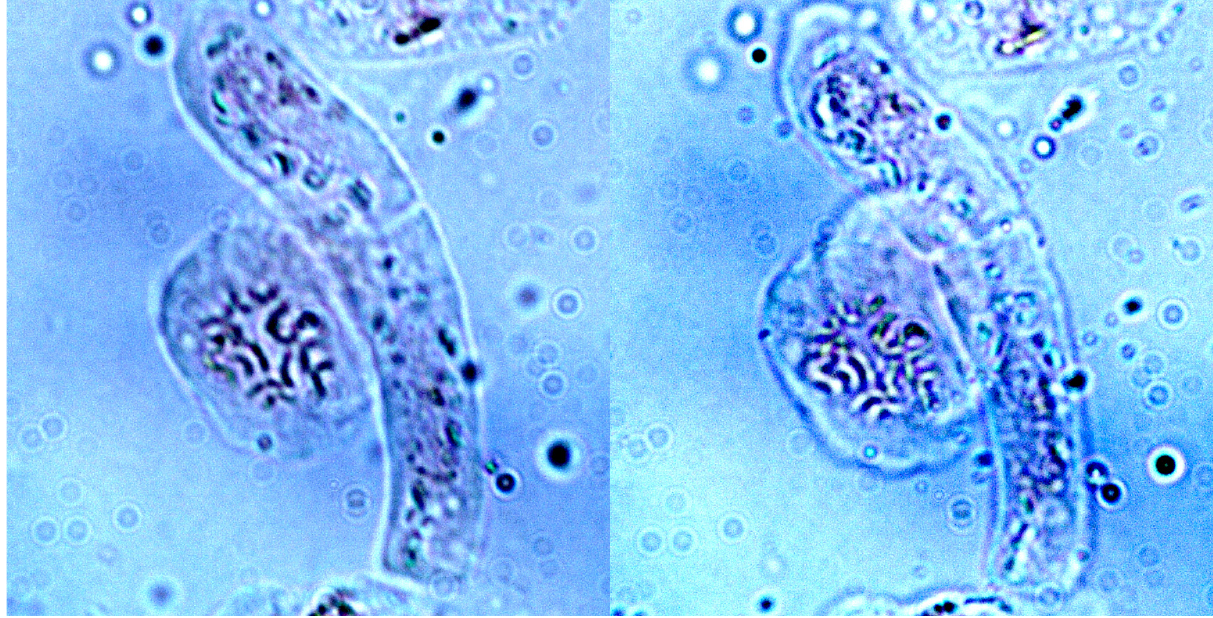
Figure 3. Mitotic metaphase. Veronica × gundisalvi ; 2n = 16.